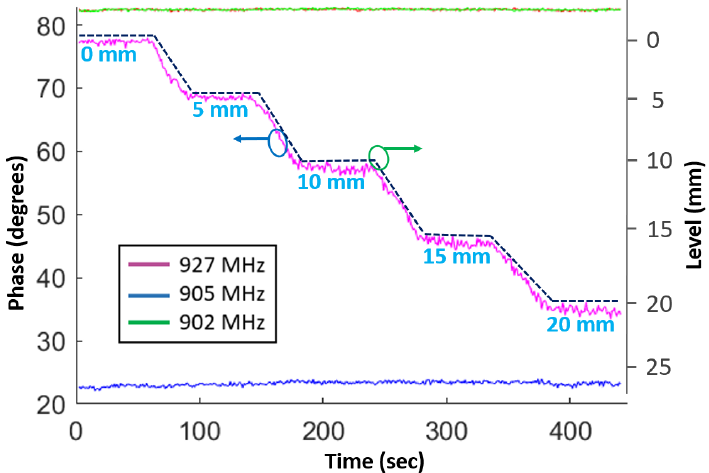
Figure 7. Sensor phase variation with respect to change in the liquid level in